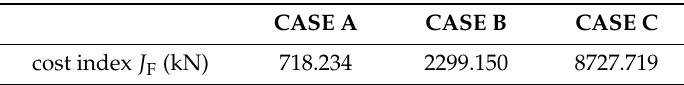
Table 4. The cost index J F of CASE A, CASE B and CASE